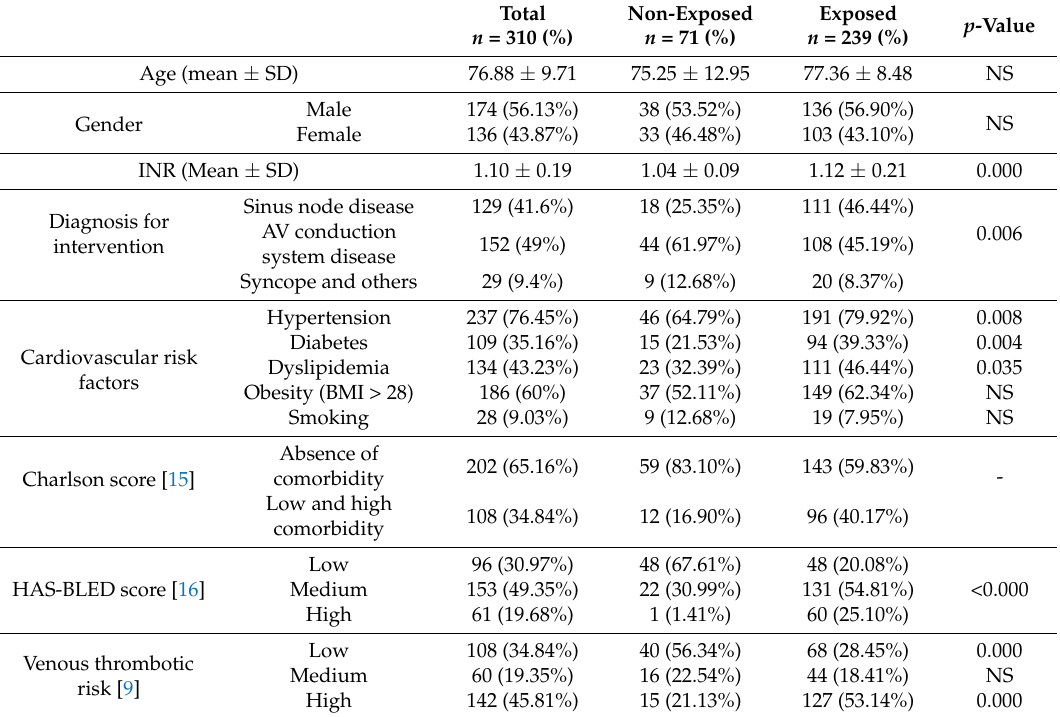
Table 2. Pre-implant clinical and biological values